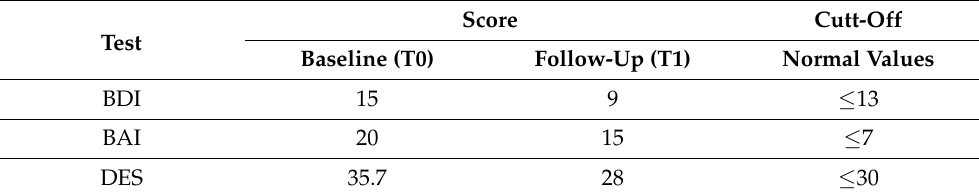
Table 2. Psychological scales: baseline (T0) and follow-up